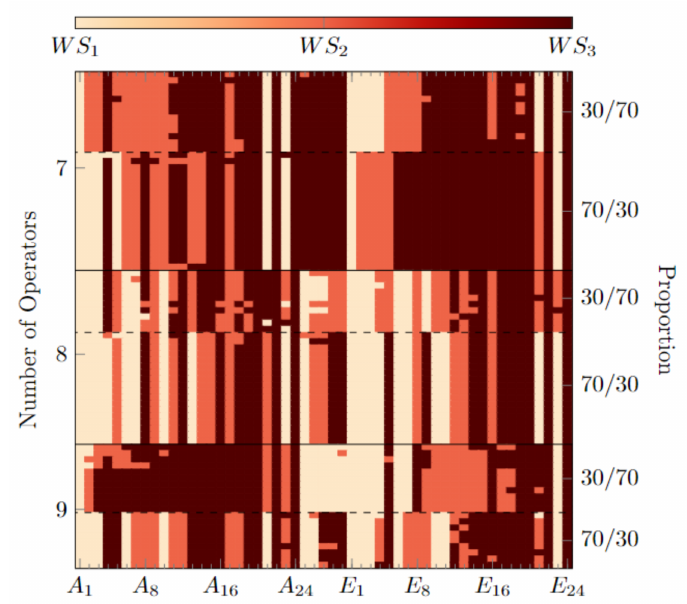
Figure 7. Task assignment in the non-dominated solutions for the RMS